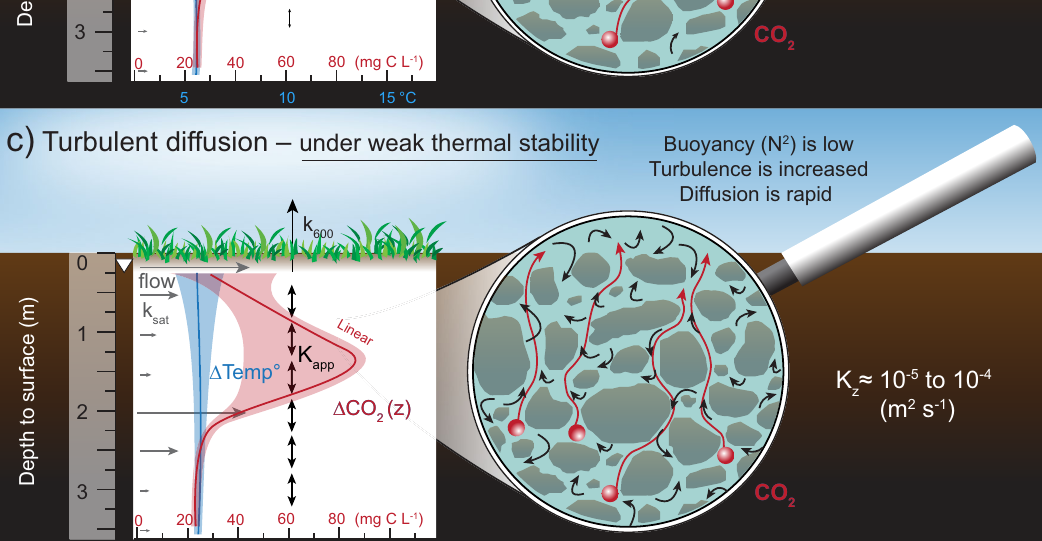
Fig. 5 Schematic of the different rates of vertical CO 2 diffusion in the catotelm porewater. From slowest to fastest: in a molecular diffusion, b turbulent diffusion during periods of strong porewater thermal stability (e.g. growing season) and c turbulent diffusion during periods of weak porewater thermal stability (e.g. autumn). Each panel shows the depth pro fi le of porewater CO 2 concentration (red line and area) and temperature (blue line and area), with the presumed saturated hydraulic conductivity ( k sat , grey arrows) based on bulk density (Supplementary Fig. 2) and Campeau et al. 13 . Each panel also includes a magnifying glass illustrating the scale of vertical porewater CO 2 diffusion (red spheres and arrows) and turbulence (black arrows) in the catotelm porewater. In a , the apparent diffusion coef fi cient ( K app ) is at the molecular rate, which is slow and constant over time (below 10 − 7 m 2 s − 1 ), resulting in a steep convex porewater CO 2 depth gradient ( Δ CO 2 ( z )). In b , turbulence is present in the porewater, but it is suppressed by the strong thermal stability (high buoyancy (N 2 )), which results in a slow vertical CO 2 diffusion, nonetheless exceeding the molecular rate, yielding a persistently convex Δ CO 2 ( z ). In c , the weak thermal stability (low N 2 , K app increases) allows turbulence to propagate in the catotelm, which enhances vertical porewater CO 2 diffusion (upwards or downwards), potentially leading to variable Δ CO 2 ( z